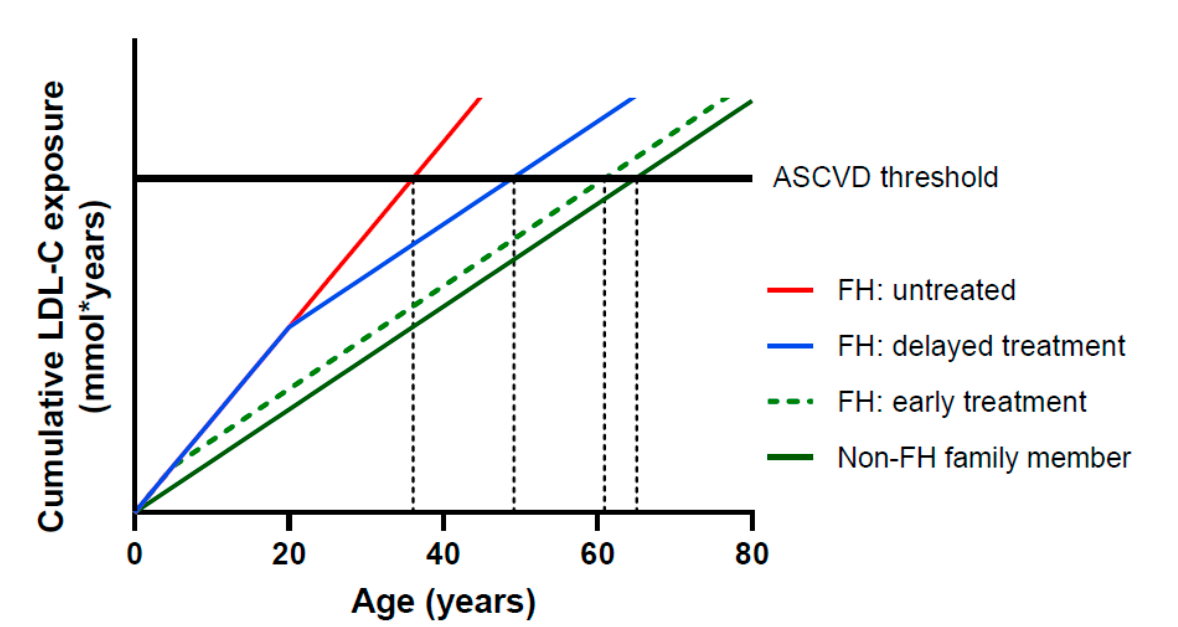
Figure 1. Relationship between cumulative LDL-C exposure and age. The horizontal black line represents a theoretical threshold of the cumulative LDL exposure required for development of atherosclerotic cardiovascular disease (ASCVD) [15], adapted from [16].